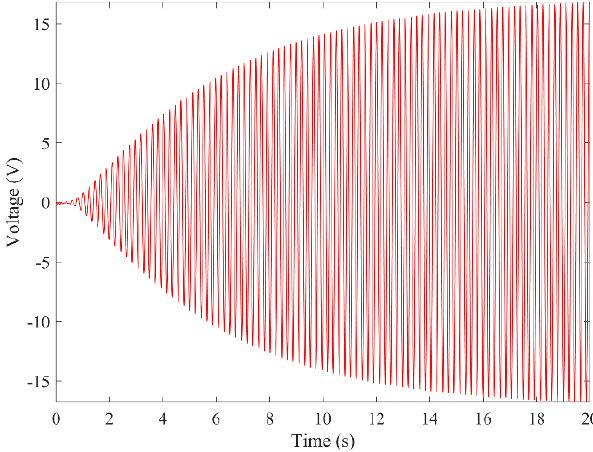
Figure 9. Time–history voltage response ( U = 1.8 m/s).